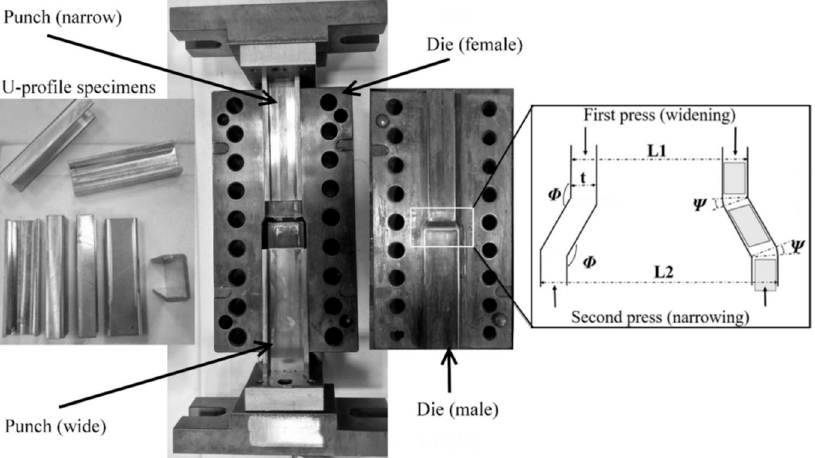
Figure 15. TWO-CAP experimental setup and parameters: U-profiles ( left ), die and punches ( middle ), channel angels ( right ).